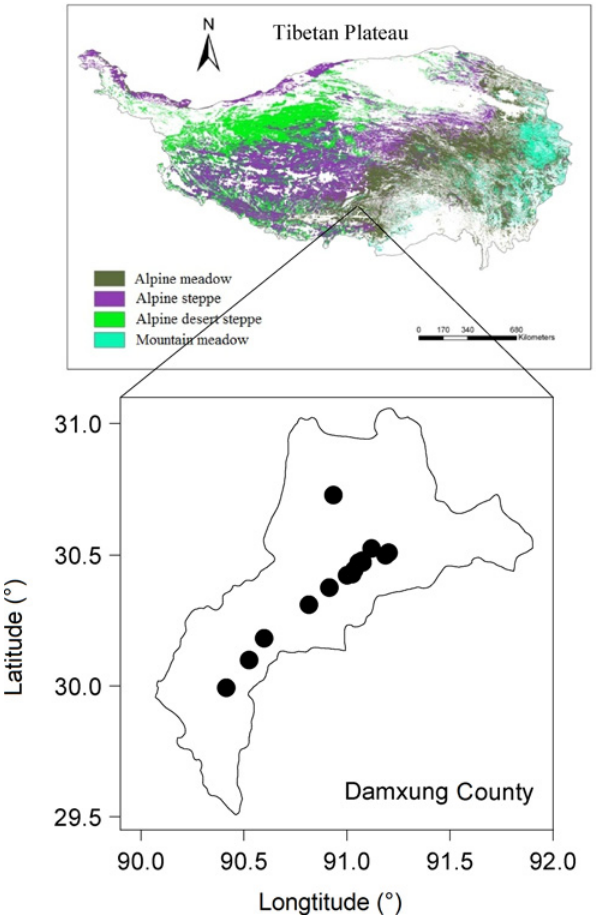
Fig 1. Sampling sites in Damxung County, Tibetan Plateau. This figure is a modification from the Vegetation Map of The People ’ s Republic of China (1:1000000) [38].